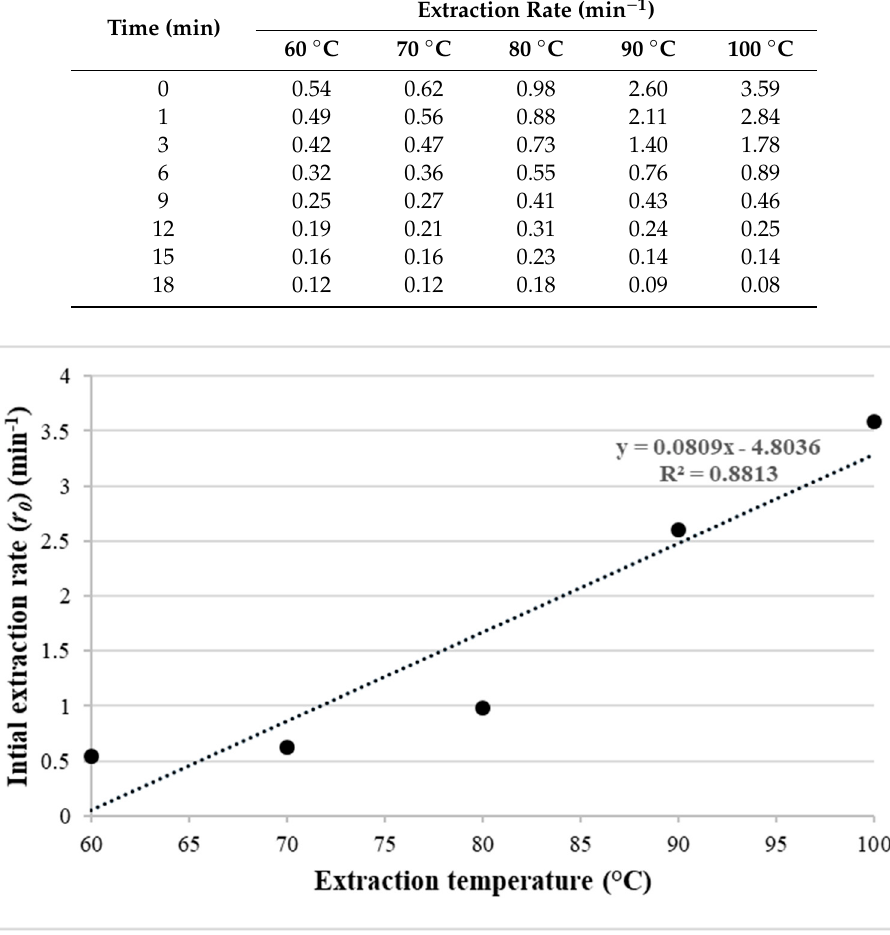
Figure 6. Effect of the extraction temperature on the initial extraction rate of Nannochloropsis sp. microalgae using MAE-brine, according to Patricelli kinetic model.